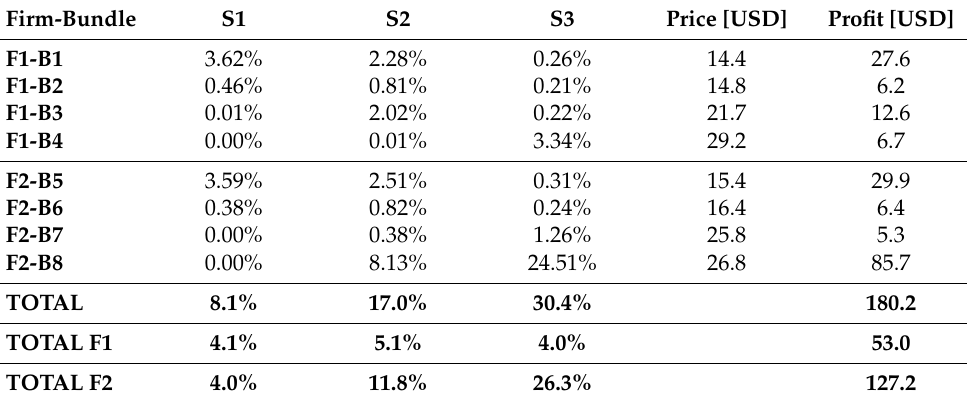
Table 13. Results for CMNL—with wp